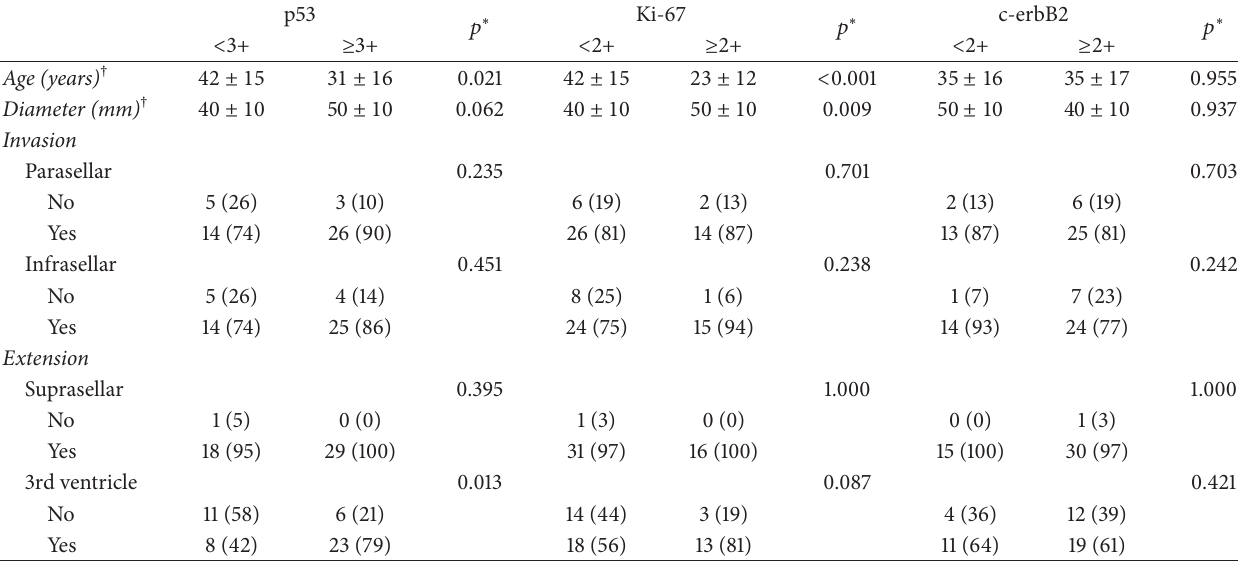
Figure 1: Immunohistochemical (IHC) analysis showing some pituitary adenomas: (a) hematoxylin-eosin; (b) prolactin; (c) GH; (d) LH; (e) FSH; (f) TSH; (g) c-erbB2; (h) Ki-67; (i) p53. The antibodies, dilutions, and reactivity scores were previously published [14, 15]. Table 3: Evaluation of p53, Ki-67, and c-erbB2 tumor proliferation markers based on clinical and radiological